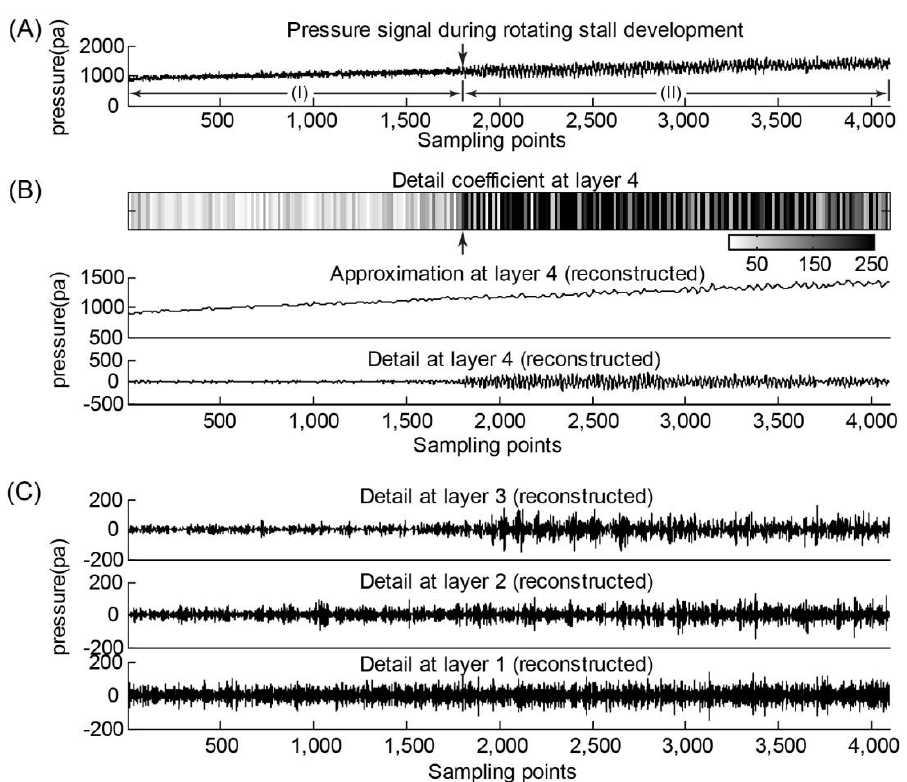
Figure 3. Fan casing pressure signal (from sensor #2) and its time-frequency map of wavelet analysis when . ( A ) Original pressure signal. ( B ) Decomposed detail component of the pressure signal at layer 4 (10–20 Hz). The detail coefficient at layer 4 indicates the energy of the pressure component caused by the fan rotation stall. ( C ) The decomposed detail components of the pressure signal at layers